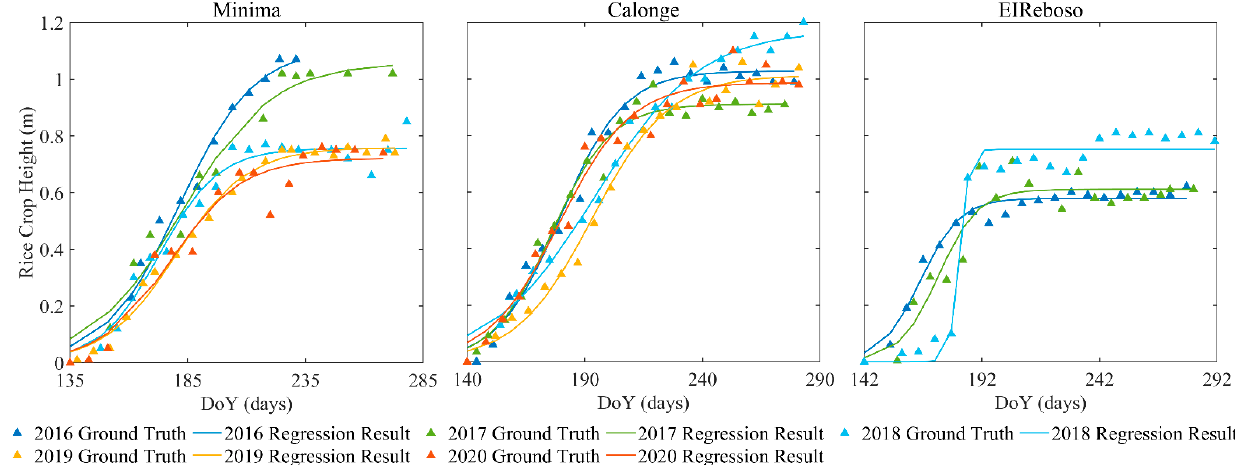
Figure 5. Regression results for the logistic growth equation with ground-truth data for the rice crop height collected from 2016 to 2020. The columns from left to right show the three monitored rice plots in Seville. Table 3. Regression results in the test sites with ground-truth data from 2016 to 2020.